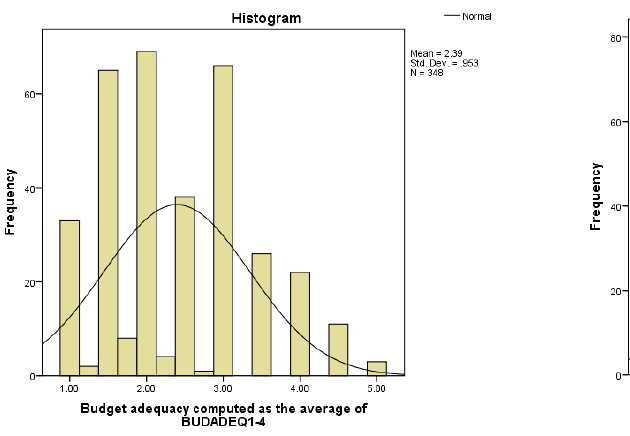
Figure 3. Normality distribution for BUDADEQ Figure 4. Normality distribution for